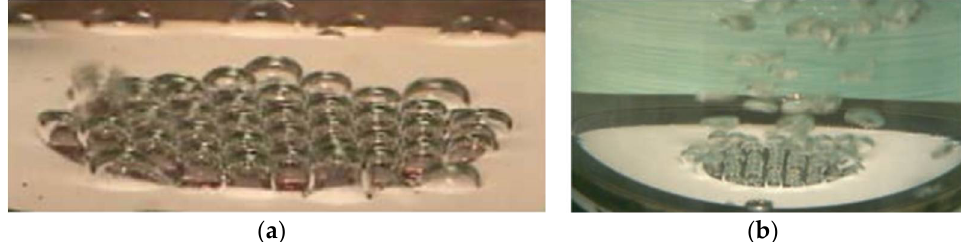
Figure 21. Behavior of boiling bubbles on the super-water-repellent (SWR) surface ( a ) and polytetrafluoroethylene (PTEE) surface ( b ). Reprinted with permission from Ref [112]. Copyright 2012 World Scientific Publishing Company.